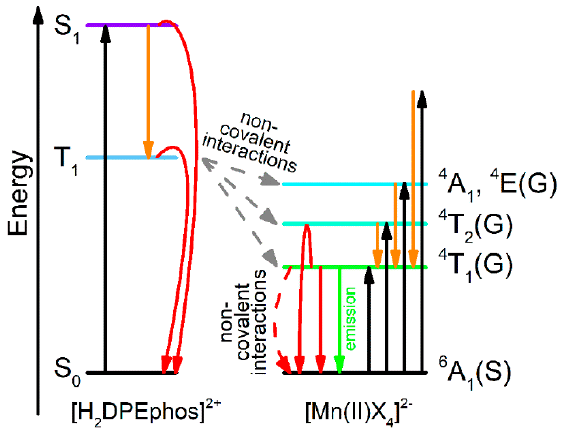
Figure 4. Representation of the energy absorption, transfer, and emission processes in 1 and 2 ( —absorption, —internal conversion and intersystem crossing transition, —emission, —transfer from [H 2 DPEphos] 2+ to [MnX 4 ] 2- , —non-radiative relaxation).